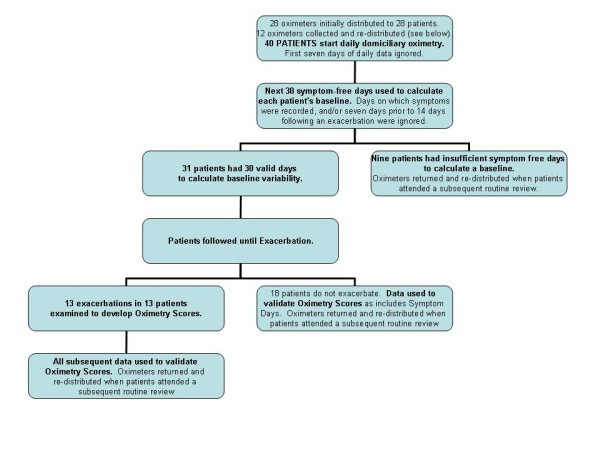
Study Profile. Study profile summarising distribution of oximeters and data collection. No data were used in more than one analysis.